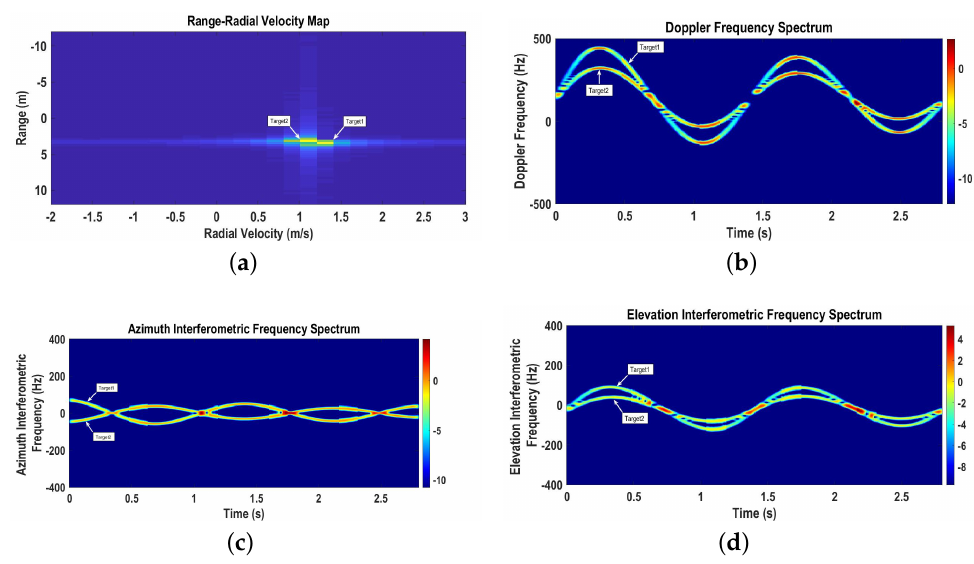
Figure 4. Range–radial velocity map, time-varying Doppler, and azimuth interferometric and el- evation interferometric spectrograms for Scenario 1. ( a ) Range–radial velocity map; ( b ) Doppler spectrogram; ( c ) Azimuth interferometric spectrogram; ( d ) Elevation interferometric spectrogram.